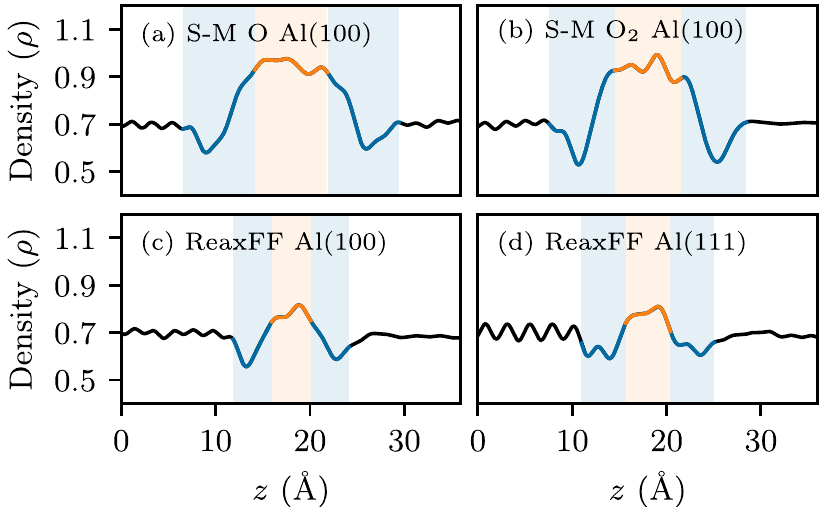
Fig. 10 Density pro fi les for various simulation parameters. a – d The density of Al/AlO x /Al junction models as a function of z (averaged over the x and y dimensions). Low densities are consistently observed at the Al – AlO x interfaces. The blue and orange shaded regions are used to determine the minimum and mean densities, respectively, for Fig. 11. This calculation was performed with the S – M potential.